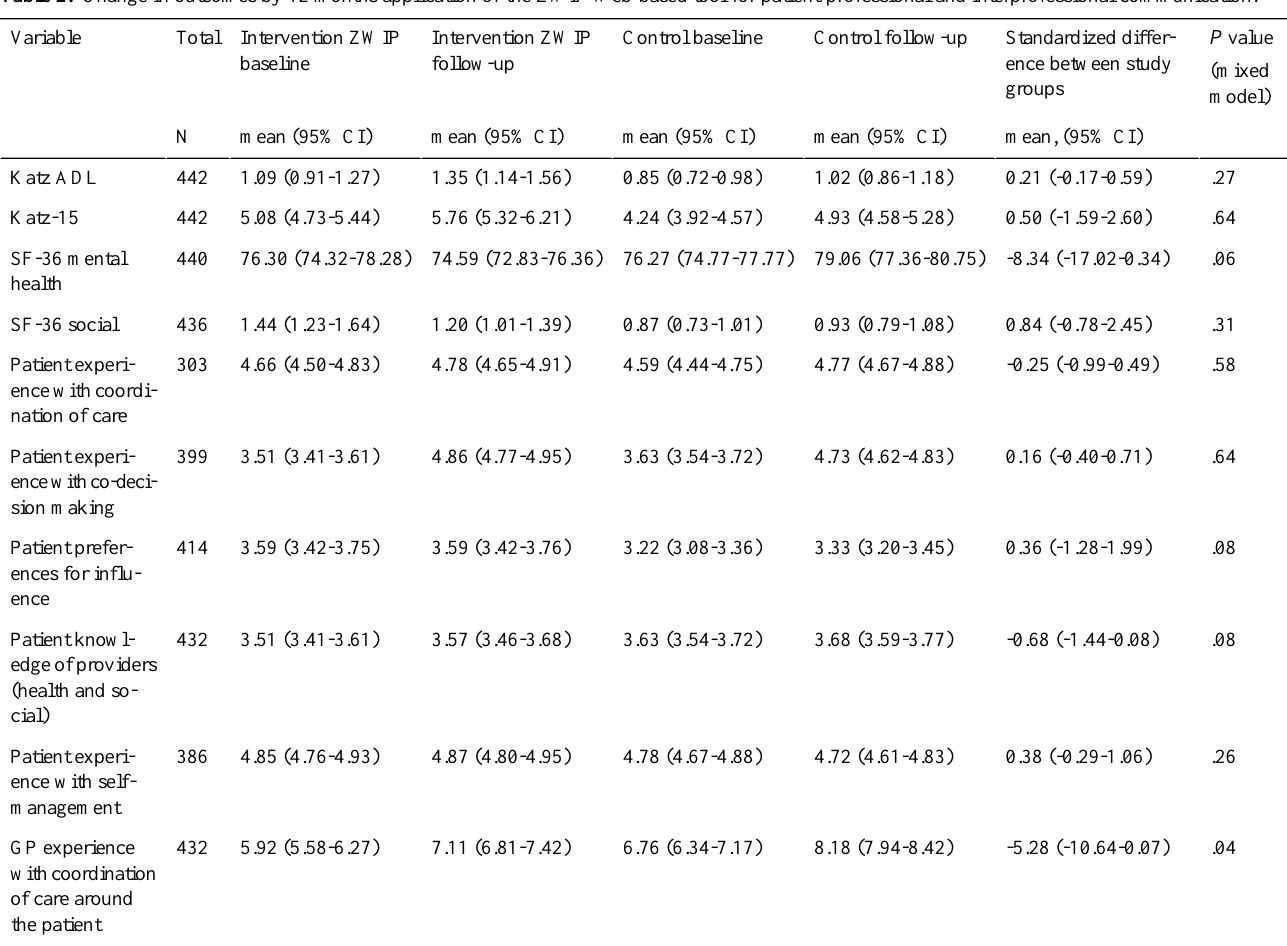
Table 2. Change in outcomes by 12 months application of the ZWIP Web-based tool for patient-professional and interprofessional communication.